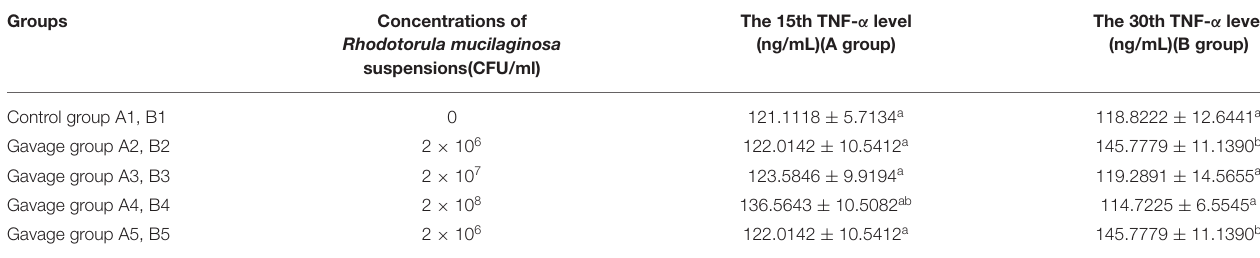
TABLE 5b | Effects of R. mucilaginosa on TNF- α content in mouse serum. Groups